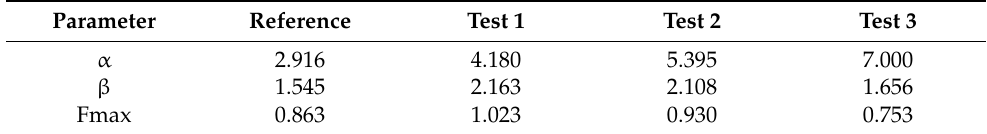
Table 4. Time ‐ corrected Weibull parameters. Table 4. Time-corrected Weibull